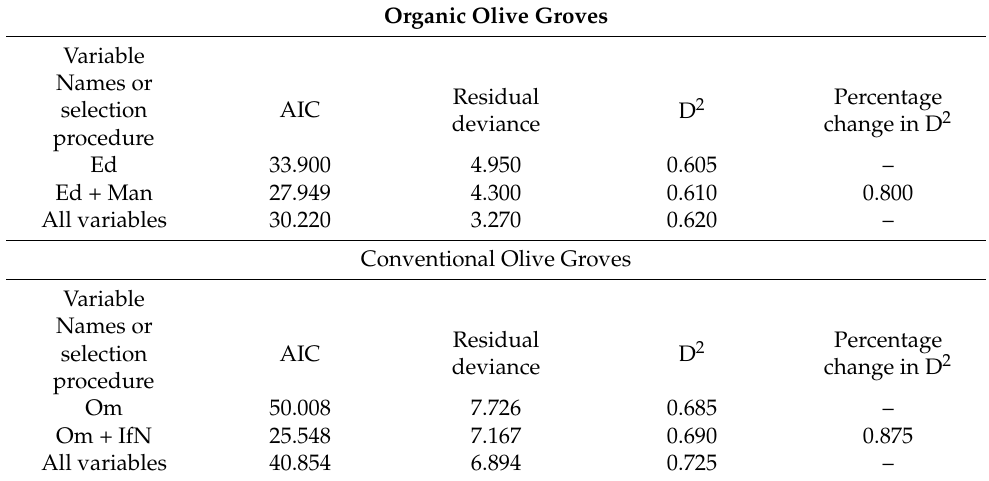
Table 2. Selection of model